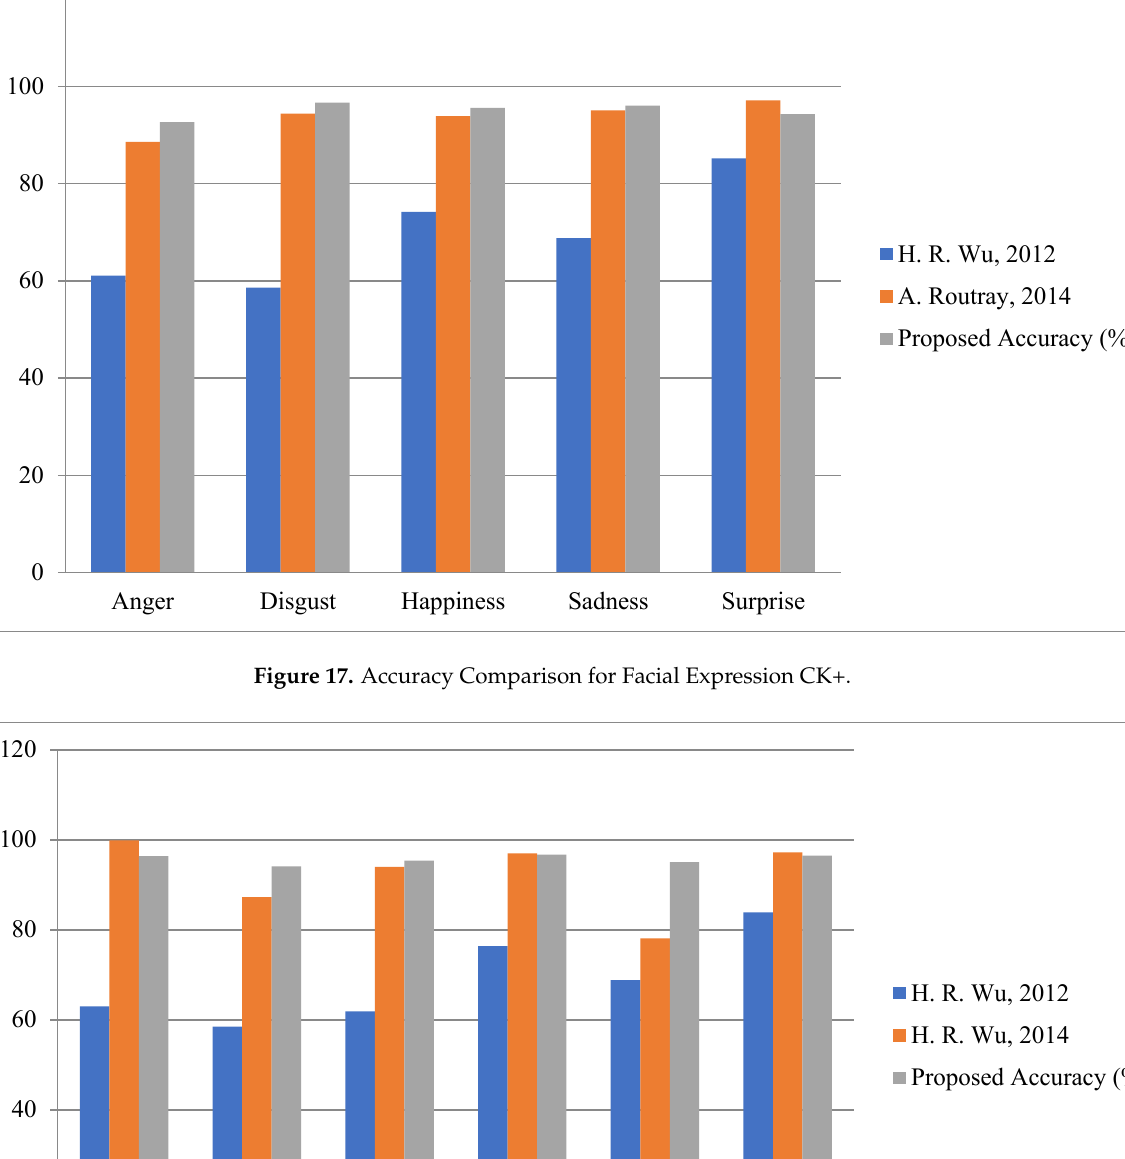
Table 8. Accuracy Comparison for Facial Expression CK+.